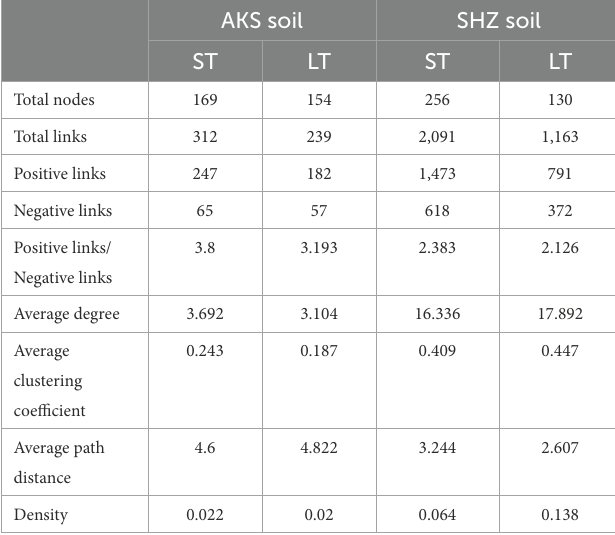
TABLE 2 Topological properties of the four co-occurrence networks in Figure